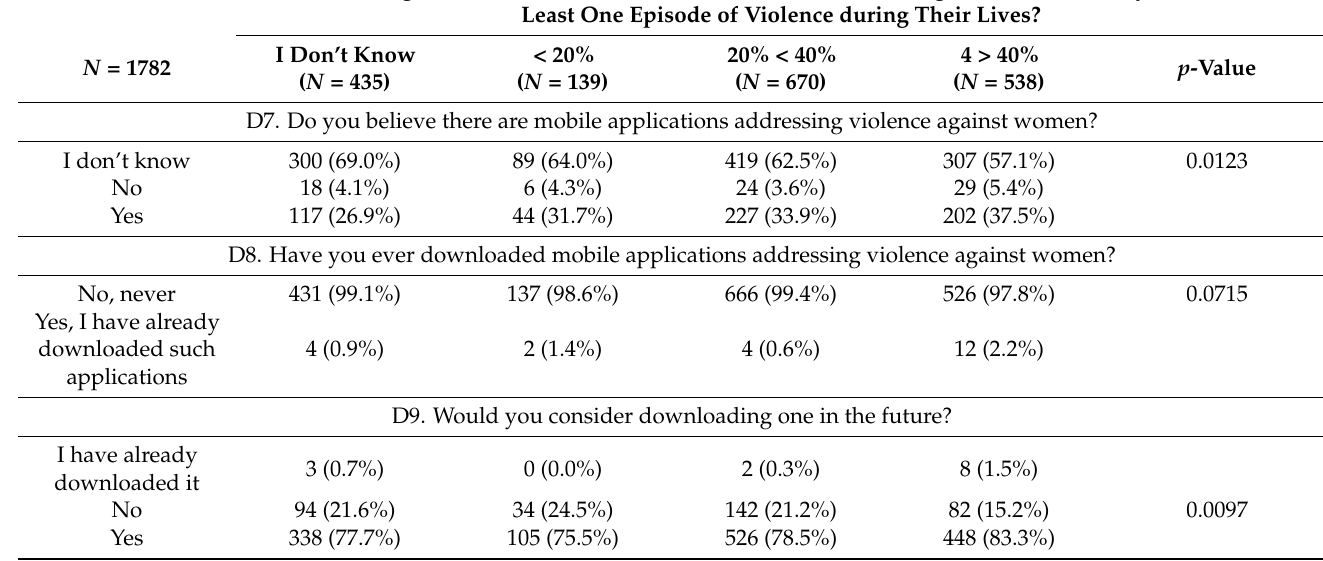
Table 2. The percentage of women who are unaware of the existence of these apps is higher among those who do not know how many women have suffered at least one episode of violence. Furthermore, the percentage of those who would download the app is higher among the respondents who believe that the percentage of women who have suffered violence is greater than 40%. Table 2. Association between the knowledge of the extent of the phenomenon of violence against women, the awareness of the existence of these apps and the aptitude to download